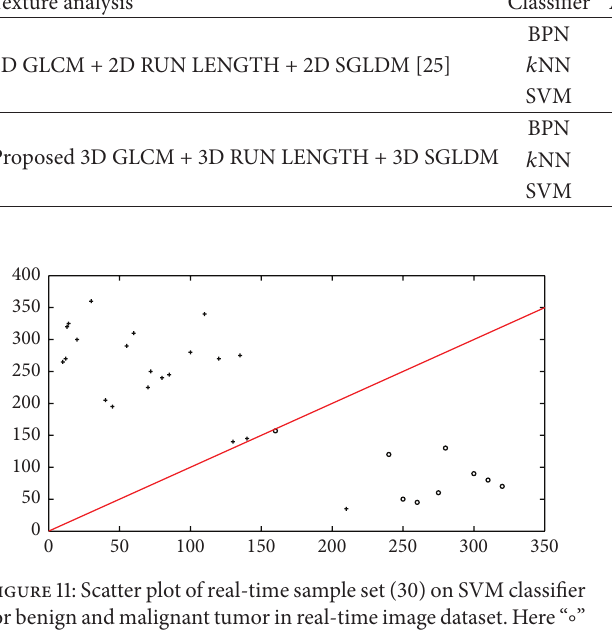
Table 6: Performance analysis of classifiers and feature extraction, both 2D and 3D. Texture analysis